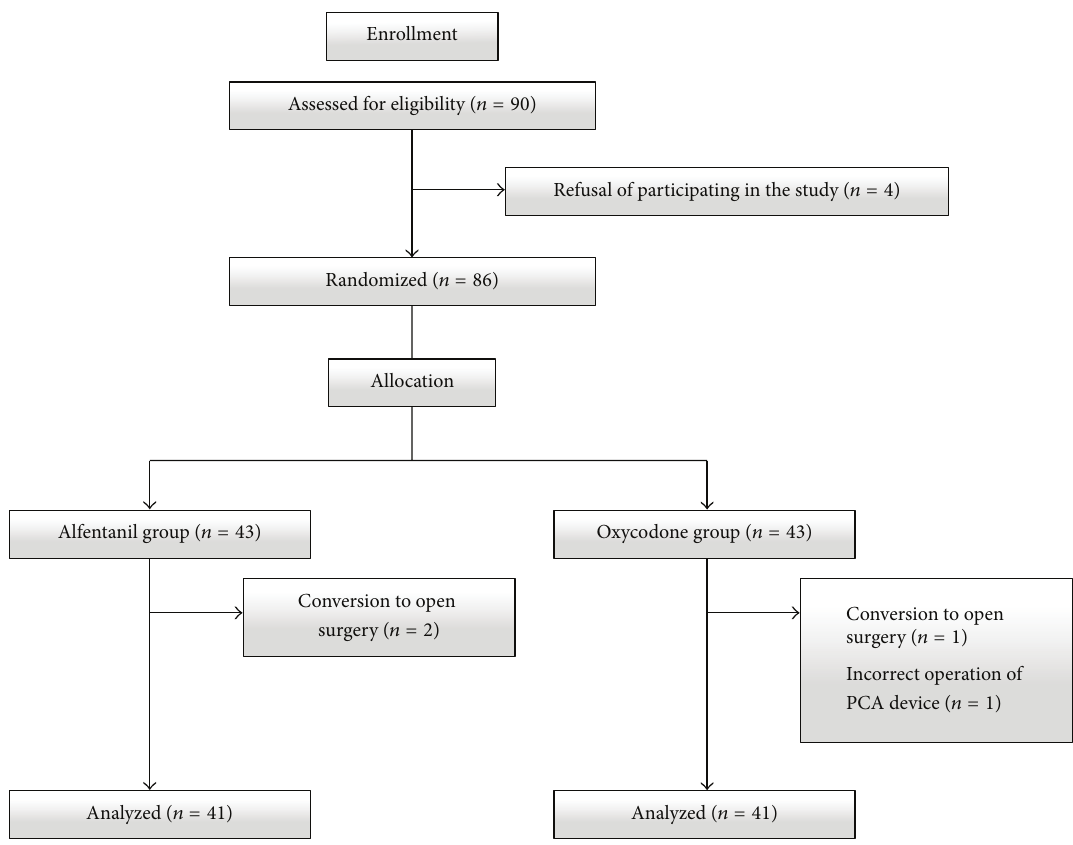
Figure 1: CONSORT